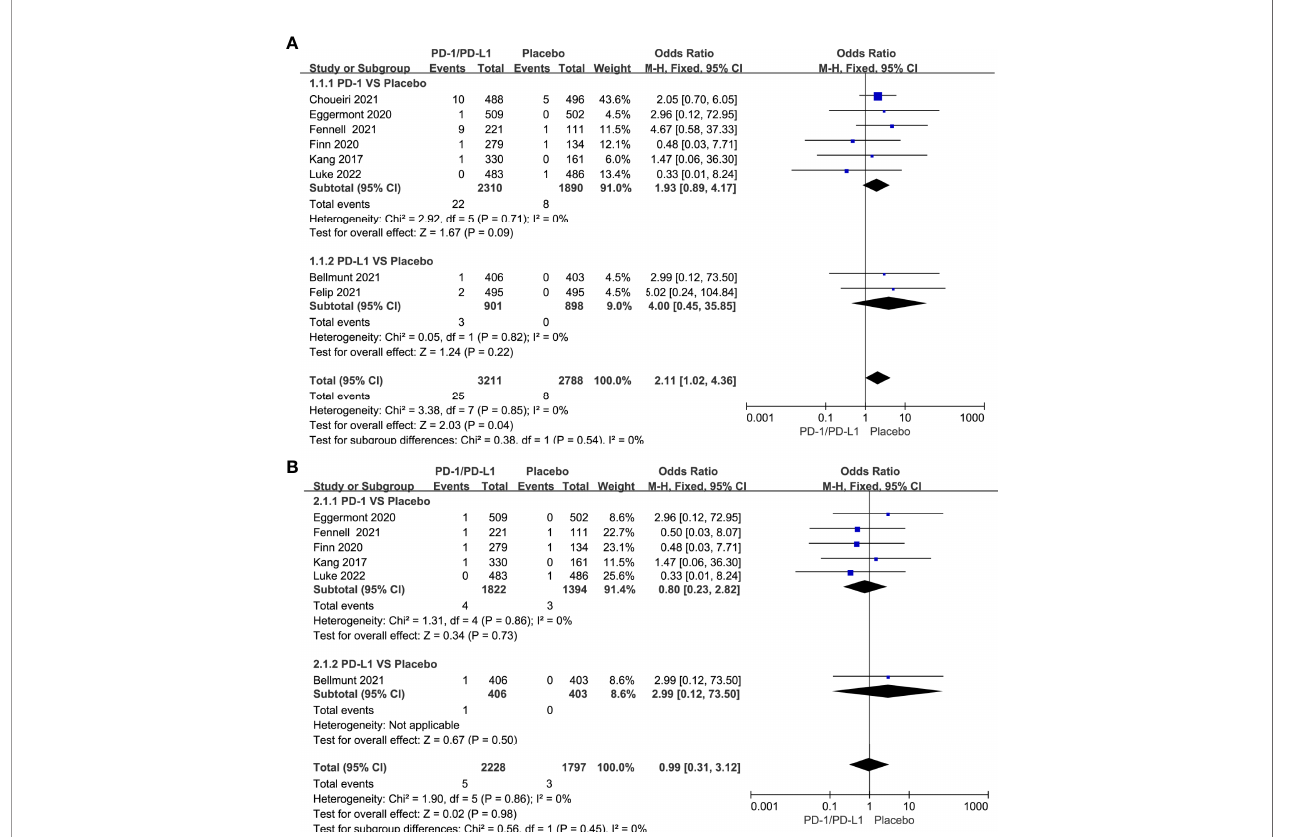
FIGURE 3 | Forest plots of the risk of all-grade and grade 3-5 cardiotoxicity calculated by the fi xed effect model. (A) The risk of all-grade cardiotoxicity in PD-1/PD- L1 inhibitors VS Placebo group. (B) The risk of grade 3-5 cardiotoxicity in PD-1/PD-L1 inhibitors VS Placebo